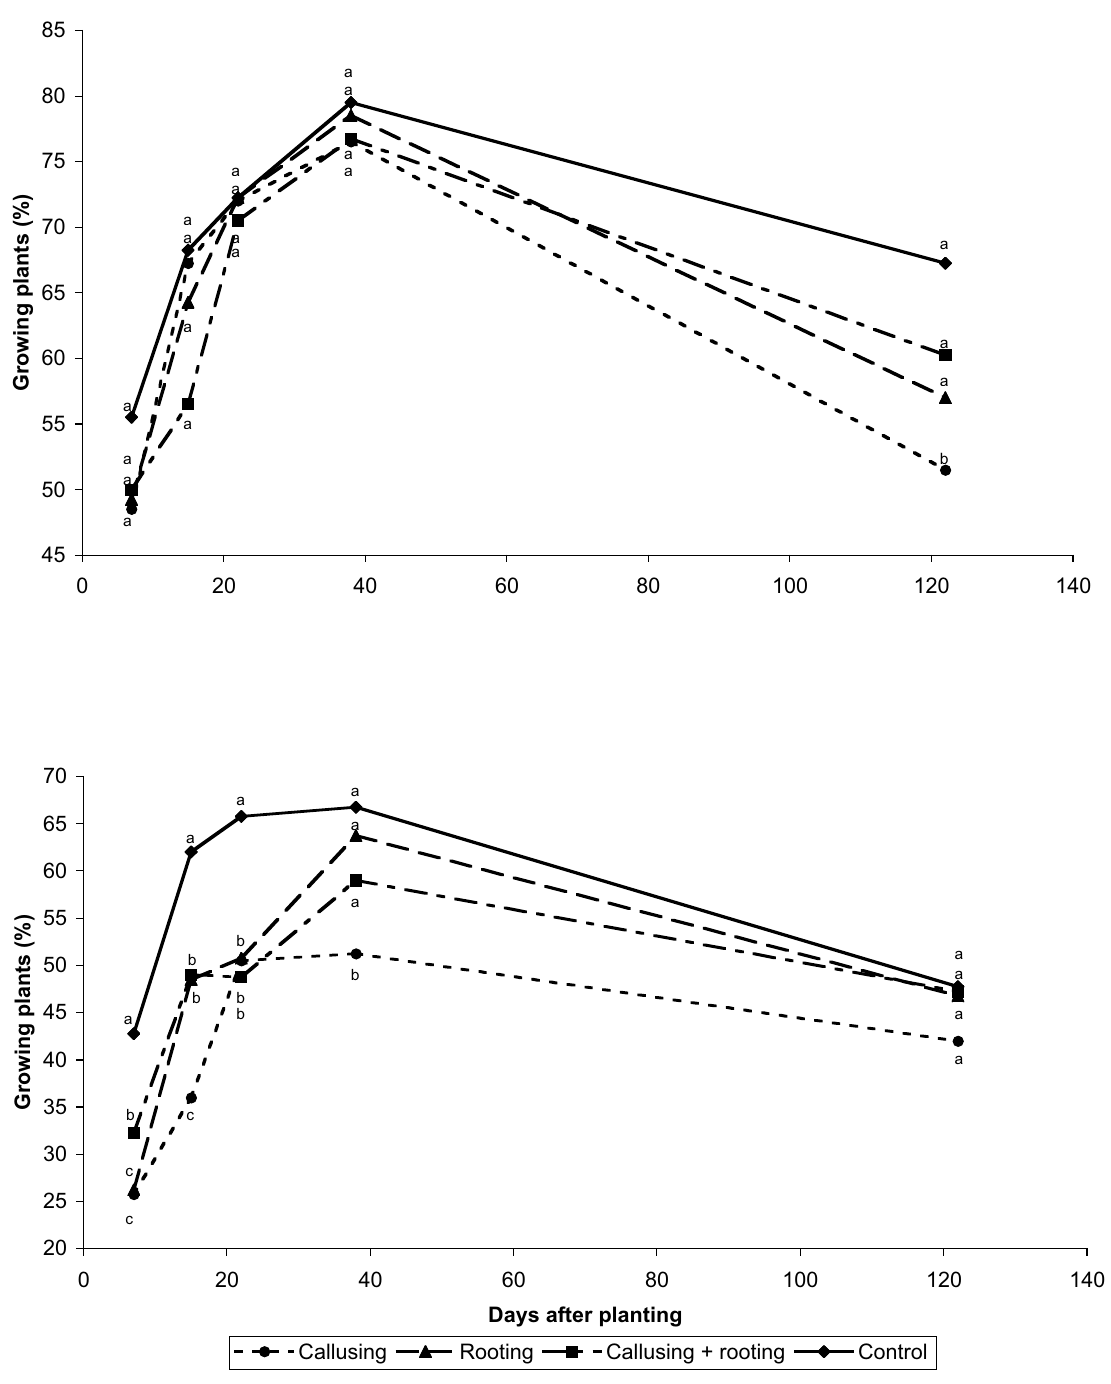
Fig. 2. Mean percentage of growing Trebbiano romagnolo plants on 1103P (top) and K5BB (bottom) treated with Trichoderma at various vine-growth stages during the nursery period. At each time of inspection, values followed by the same letter do not differ significantly according to Duncan’s Multiple Range Test ( P